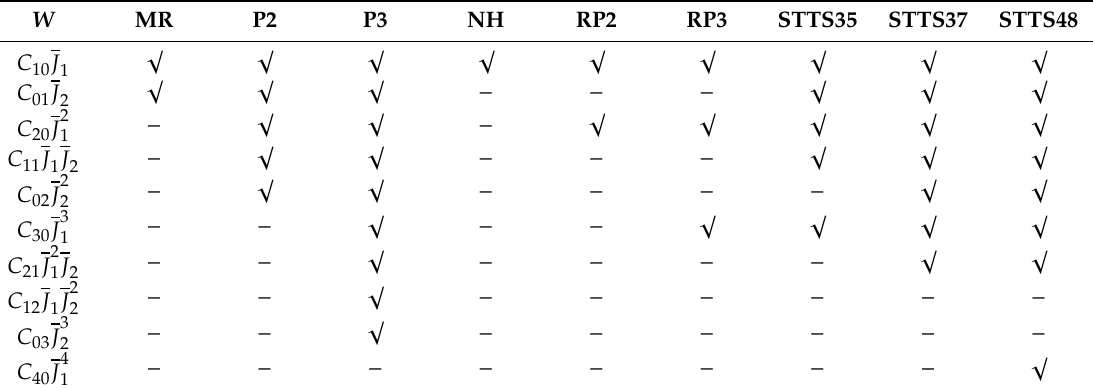
Table 8. Generalized polynomial